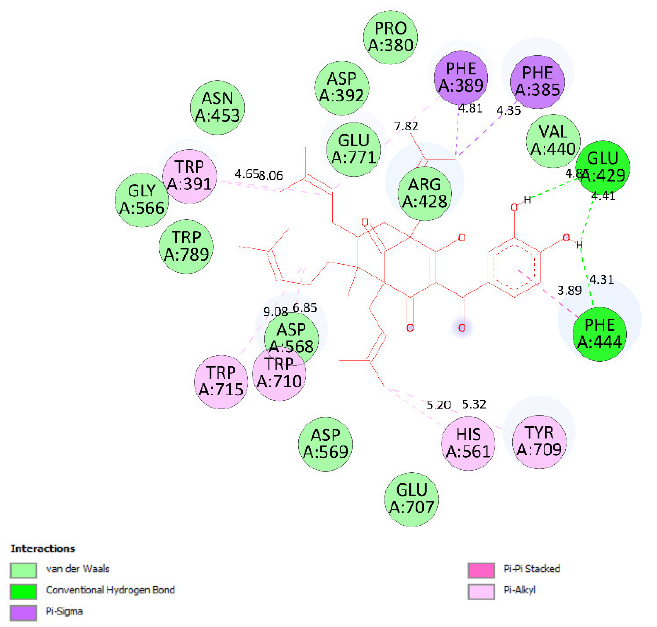
Figure 8. The role of ligand interactions between pose 41/200 and active residual amino acids on receptor 4J5T.